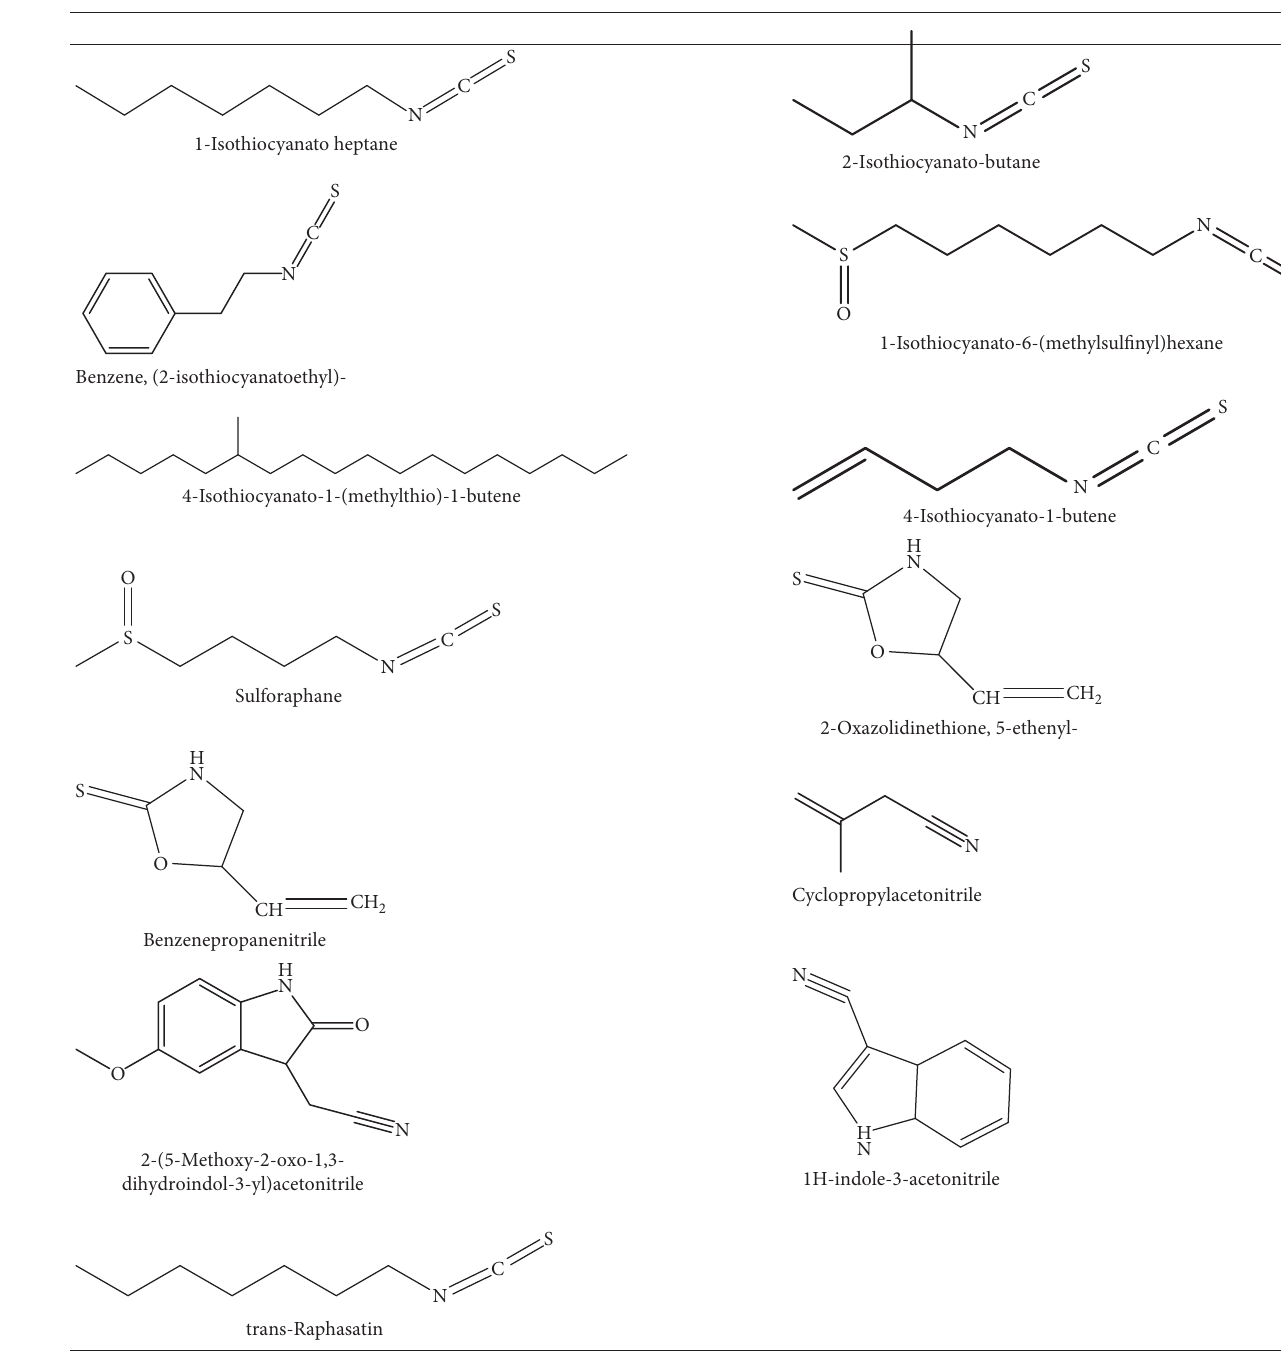
Table 1: Structure of glucosinolate metabolites in